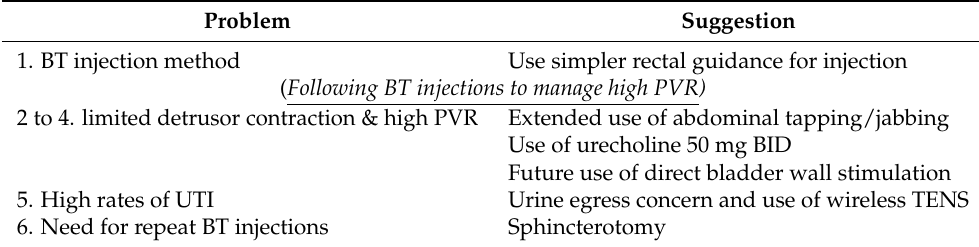
Table 2. Six problems and suggestions for RV and complete UMN